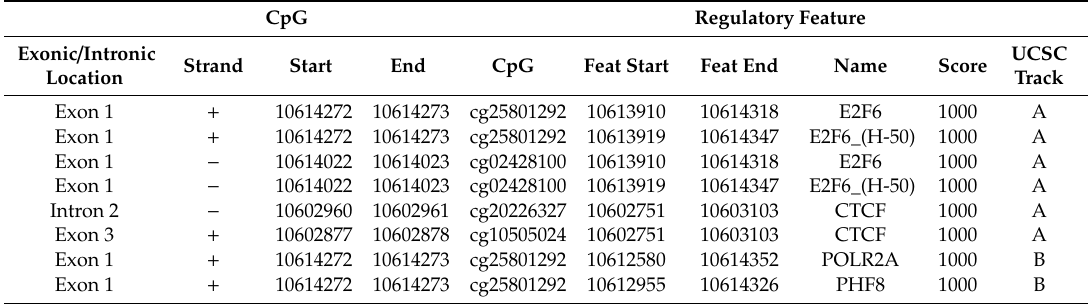
Table 4. Regulatory features co-localizing with KEAP1 CpGs.